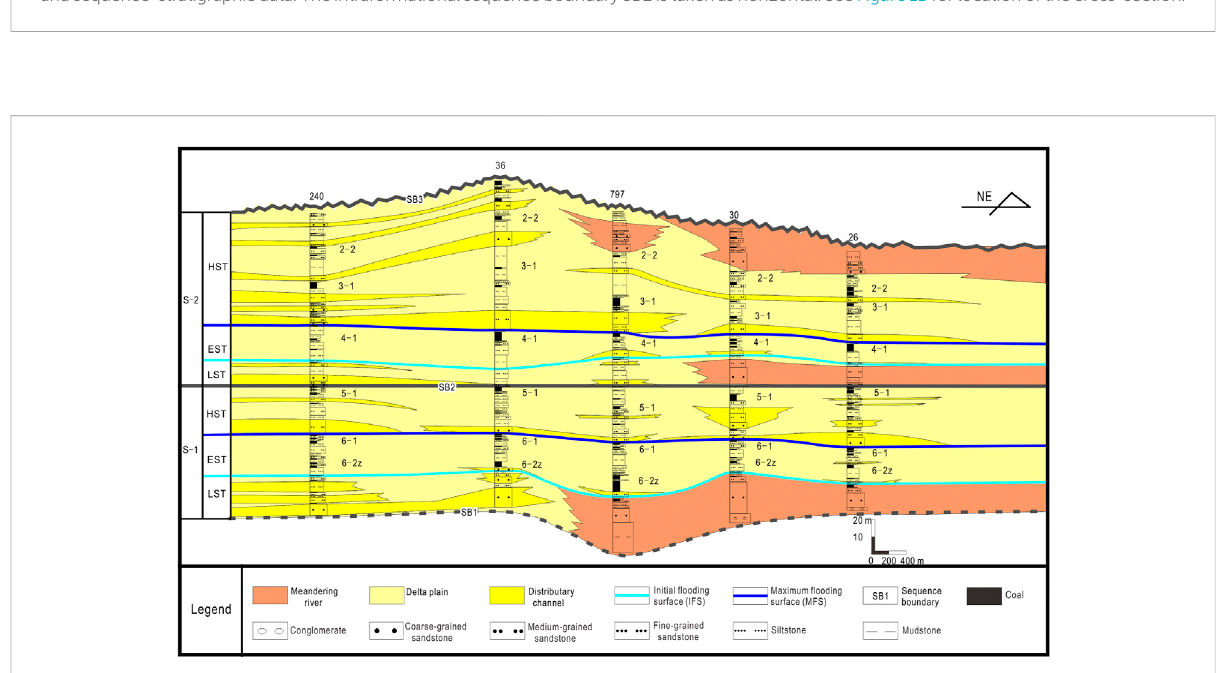
FIGURE 7 NE-SW cross-section (D-D ′ ) through the Yan ’ an Formation, showing lithofacies, interpreted depositional environments (including coal seams)